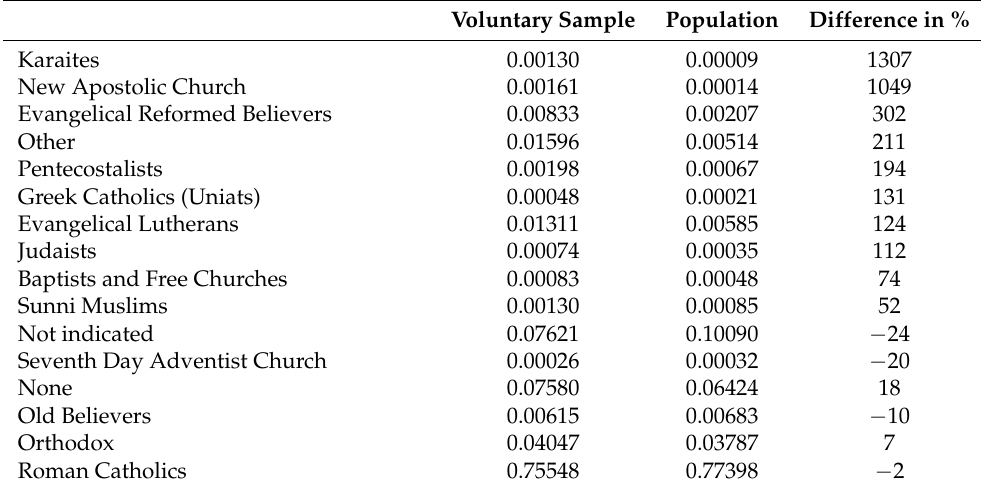
Table 2. Comparison of religion proportions in the voluntary sample and the whole